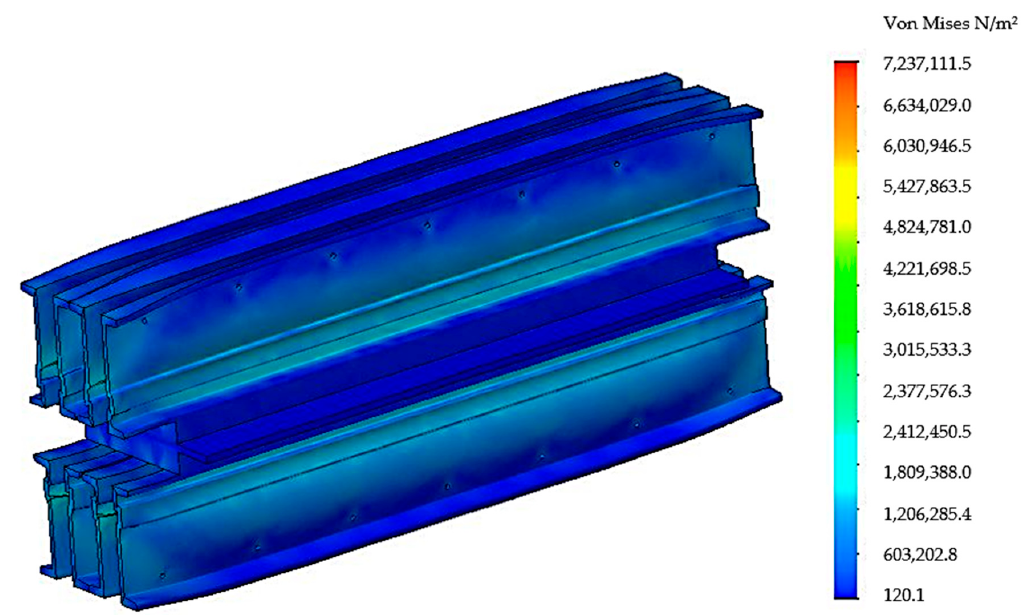
Figure 11. Distribution von Mises stress in the belt vulcanization press when using seven spacers.